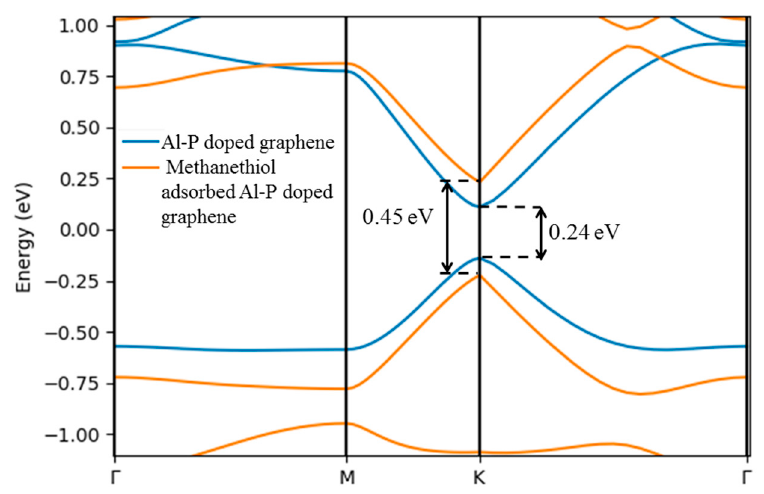
Figure 5. Band structure of Al-P-doped graphene and methanethiol adsorbed Al-P-doped gra- phene. Table 3. Physical parameters of different variants of graphene before and after methanethiol ad- sorption calculated by DFT analysis. Al-P Doped Gra- phene